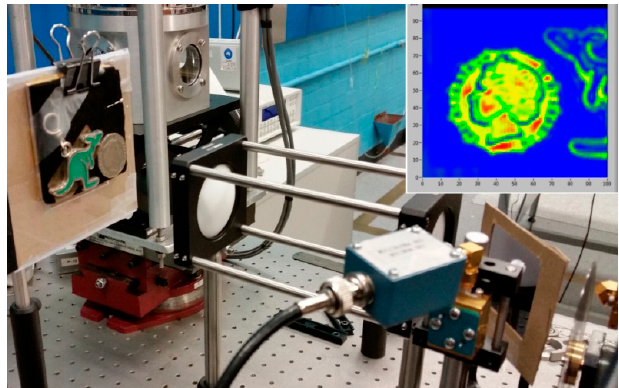
Figure 6. Imaging of a 50 cents coin and a Kangaroo key ring in a reflection mode (note that the